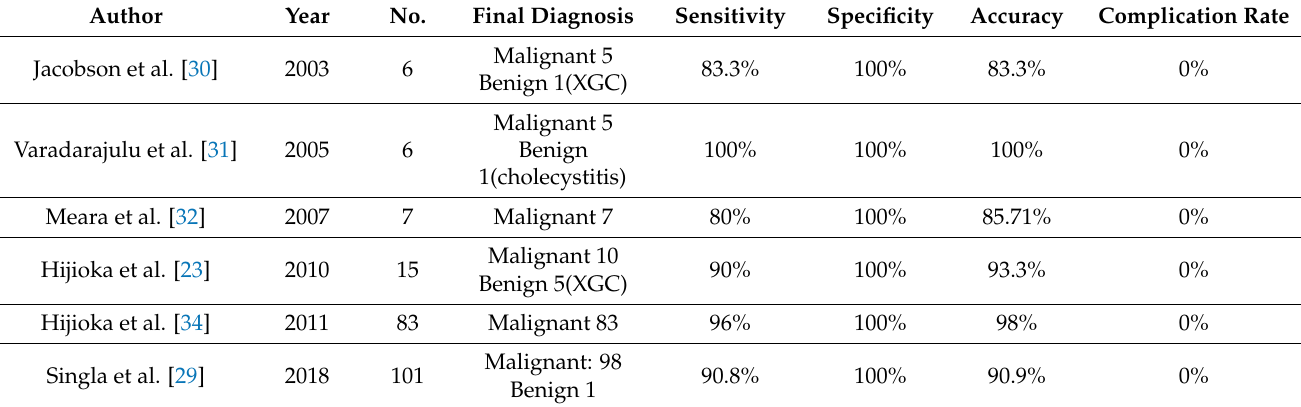
Table 2. Studies comparing the role of EUS-FNA for the gallbladder